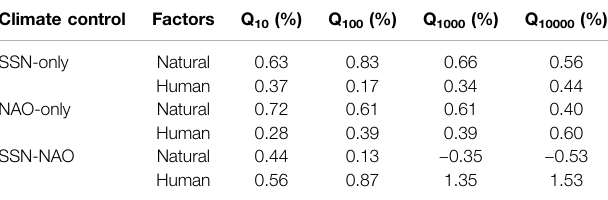
TABLE 10 | Contributions of climatic control and human activities to fl oods with different recurrence intervals. Climate